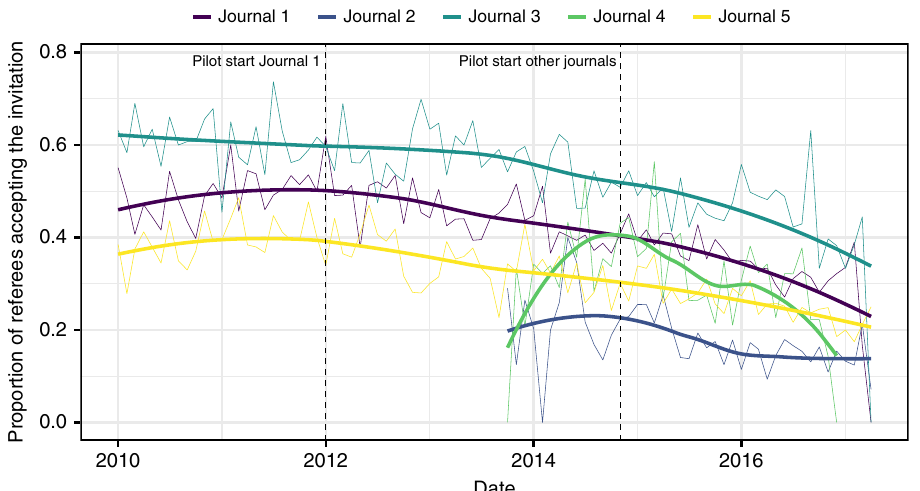
Fig. 2 Proportion of referees who accepted the editors ’ invitation by journal. Thicker curves show smoothed fi tting of the data (Loess) for each journal. The last 6 months were removed from the fi gure due to few observations